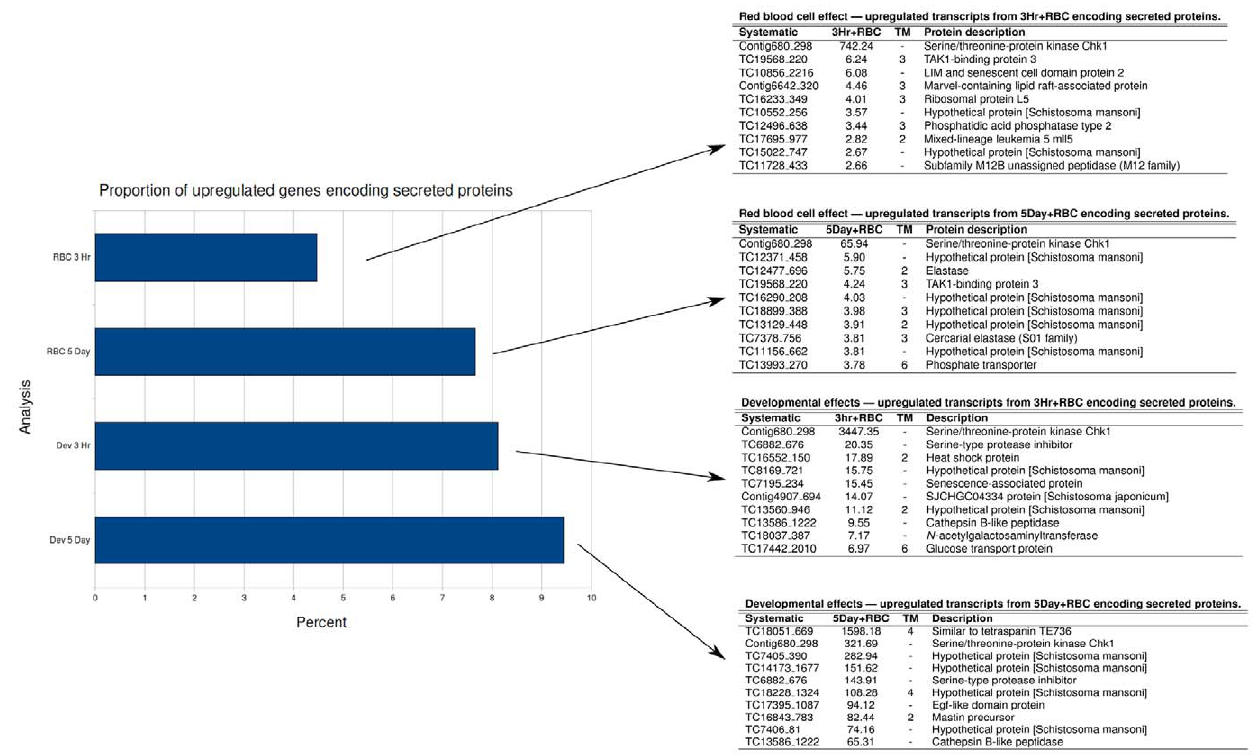
Figure 6. Percentage of genes encoding for secreted/membrane proteins that underwent $ 2-fold increased expression in each category. All genes that were up-regulated were screened for the presence of a signal peptide or anchor using SignalP; those ORFS with a signal peptide/anchor were then further screened for transmembrane (TM) domains using TMPred. The tables show the ten most highly upregulated genes in each